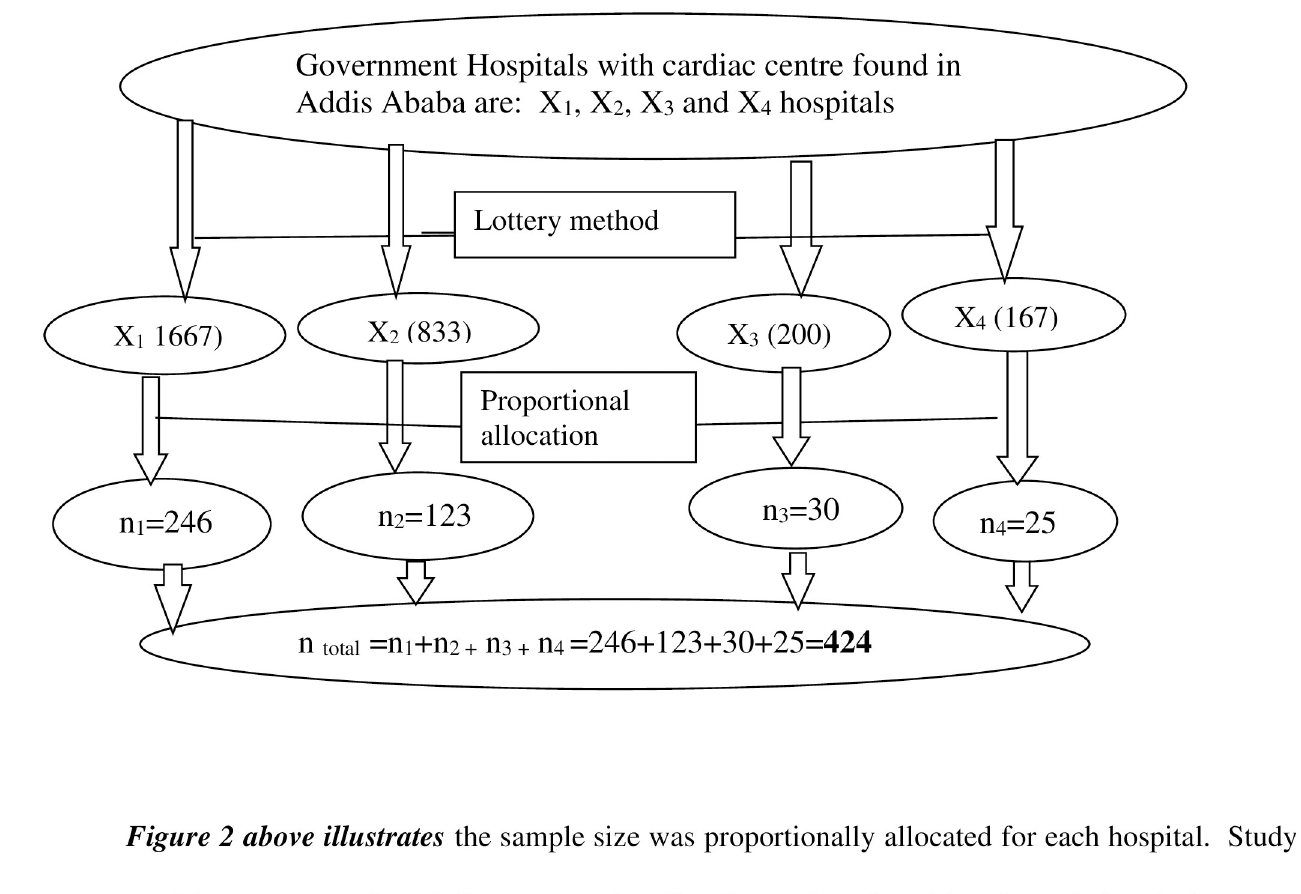
Fig 2. Schematic presentation of sampling technique and sample size proportional